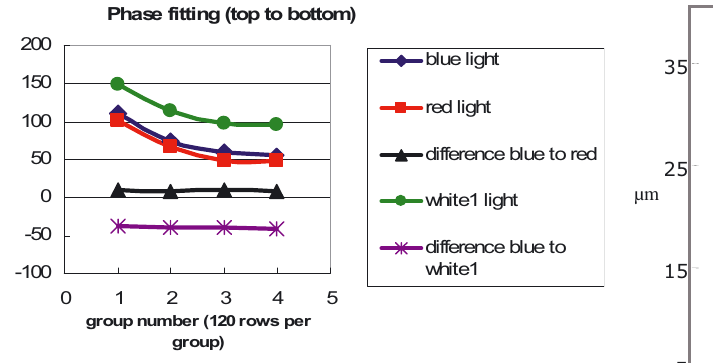
Fig. 3. Comparison of the image positions in vertical direction of the frame with different wavelengths.